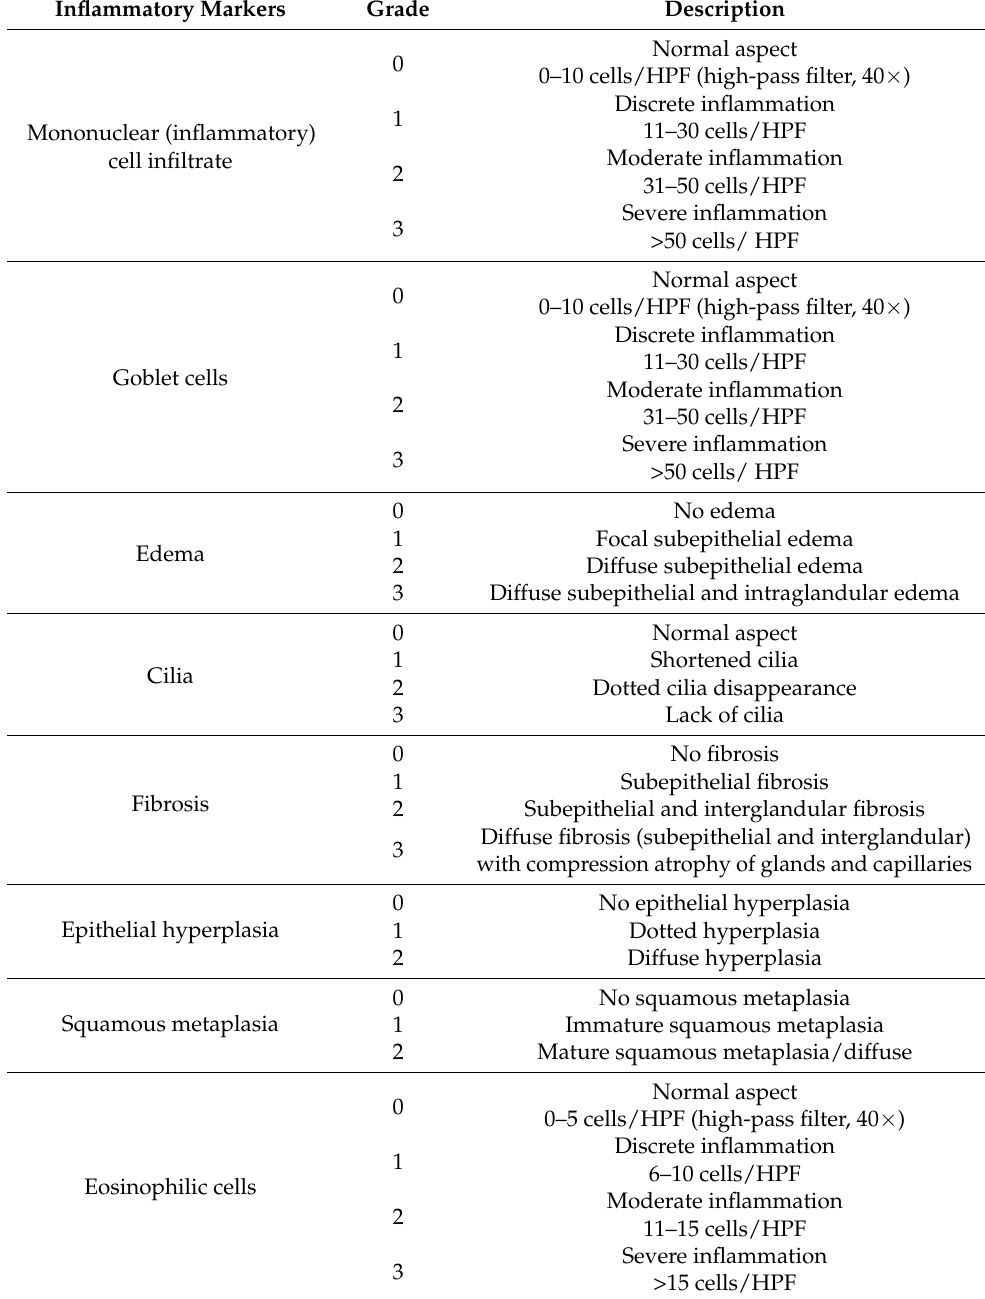
Table 1. Parameters used in the histological assessment